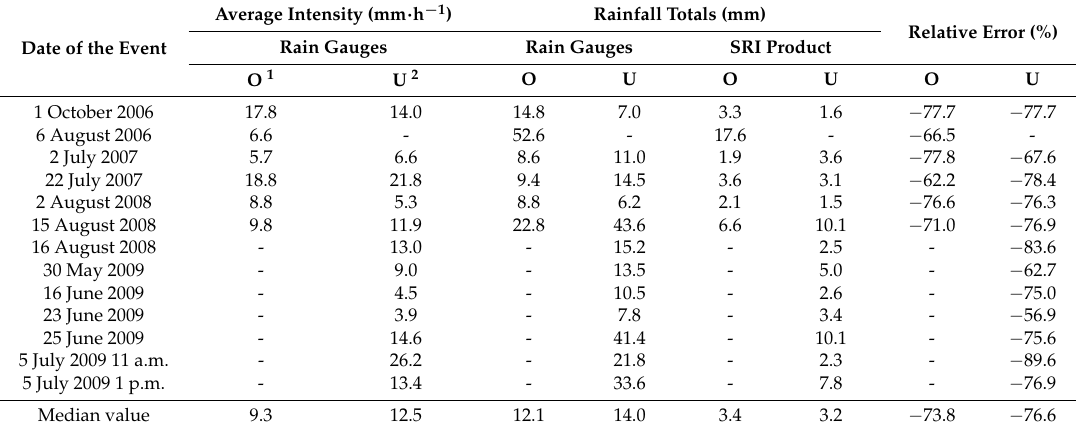
Table 1. Rainfall totals using rain gauges and SRI product